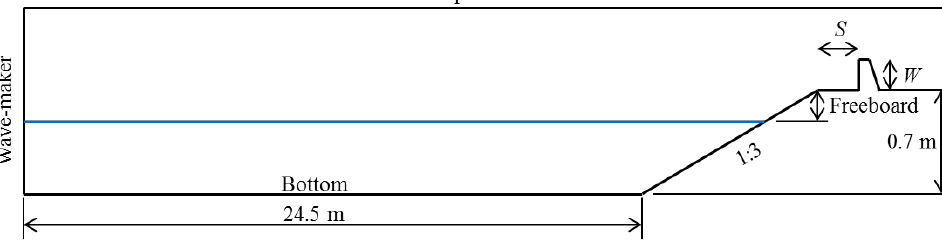
Figure 11. Sketch of the computational domain (identical to that of Tuan and Thin [18]).